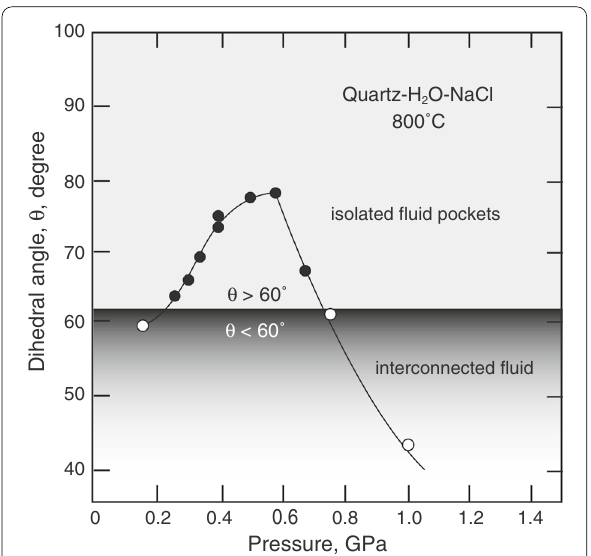
Fig. 37 Evolution of dihedral angle in quartz as a function of pressure. Modified after Holness (1992)